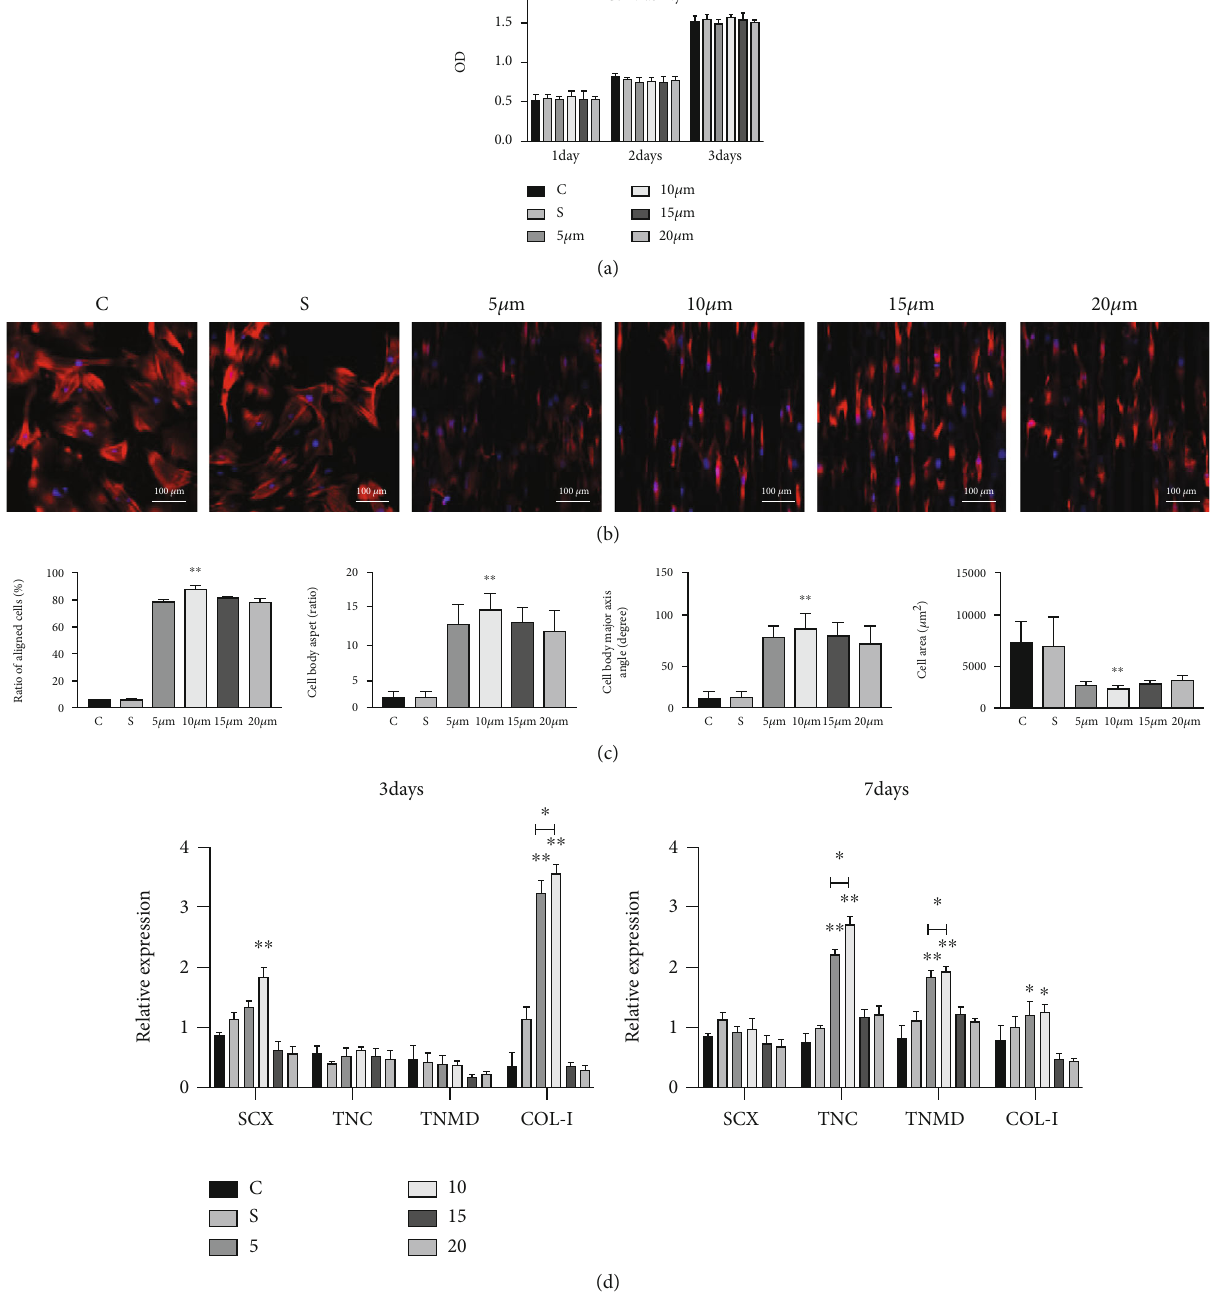
Figure 4: Cell viability on days 1, 2, and 3 was detected using the CCK-8 assay in di ff erent groups (a). Cytoskeleton and nucleus staining of TSPCs on di ff erent SF fi lm groups and control group and also the distribution of normal tendon fi bers and tendon cells (b). Quantitative analysis of the ratio of oriented aligned cells, cell body aspect, major axis angle, and cell area of TSPCs in di ff erent groups (c). Comparison of the expression levels of tendon-related genes after 3 days and 7 days (d). Group C was the normal culture plate group, group S was the SF fi lm group with a smooth surface, and the other groups were SF fi lm groups with di ff erent microstructure sizes (5, 10, 15 and 20 μ m). ∗ indicates p < 0 : 05 , ∗∗ indicates p < 0 : 01